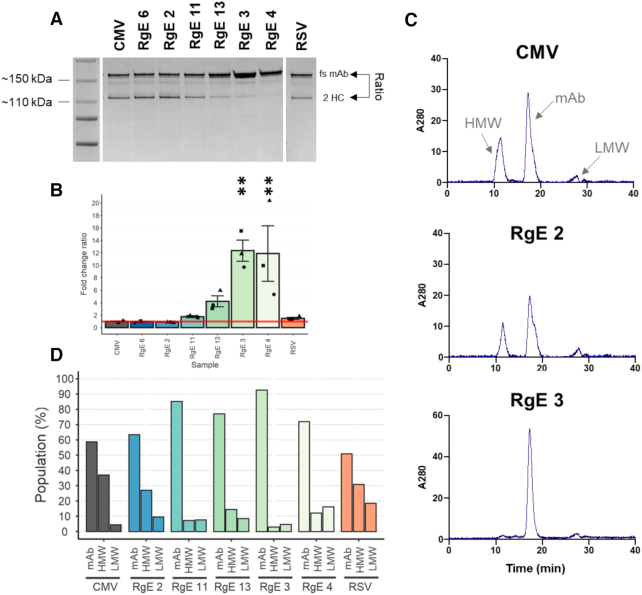
Analysis of product quality of the produced IgG. (A) Non-reducing sodium dodecyl sulphate-polyacrylamide gelelectrophoresis (SDS-PAGE) of protein-A beads purified IgG from the supernatant on day 6 post-transfection. fs = full size, 2 HC = heavy chain dimer. An image of the reduced plots can be found in Supplementary Figure S9b. (B) Calculated fold change (FC) of the ratio of fs to 2 HC from purified IgG from the supernatant on day 6 post-transfection referenced to sample CMV (n = 3 independent samples each; RgE 11: n = 2). Shapes of the data points indicate the respective replicates as indicated in Figure 4B. Gel pictures from all three replicates are shown in Supplementary Figure S9a. (C) Selected SEC chromatograms of protein A column purified IgGs produced. HMW = high molecular weight non-native fractions, LMW = low molecular weight non-native fractions, mAb = monoclonal antibody (wanted, native form of trastuzumab). All SEC chromatograms are shown in Supplementary Figure S10. (D) Calculated population distribution for respective RgE-produced IgGs based on peak areas shown as percentage of total peak areas for each chromatogram.